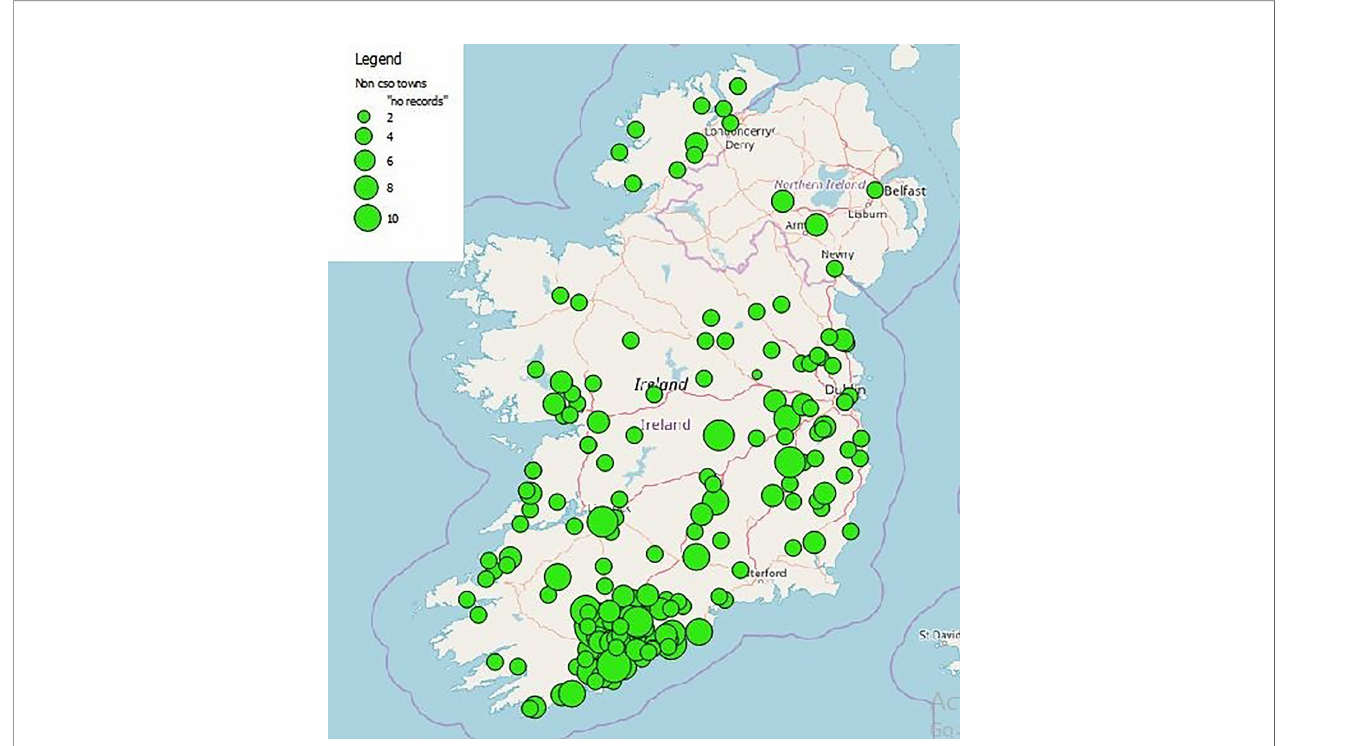
FIGURE 1 | Ladybird records submitted at locations with human population less than 1500 (Central Statistics Of fi ce, 2021a). Circle size re fl ects the number of records (total